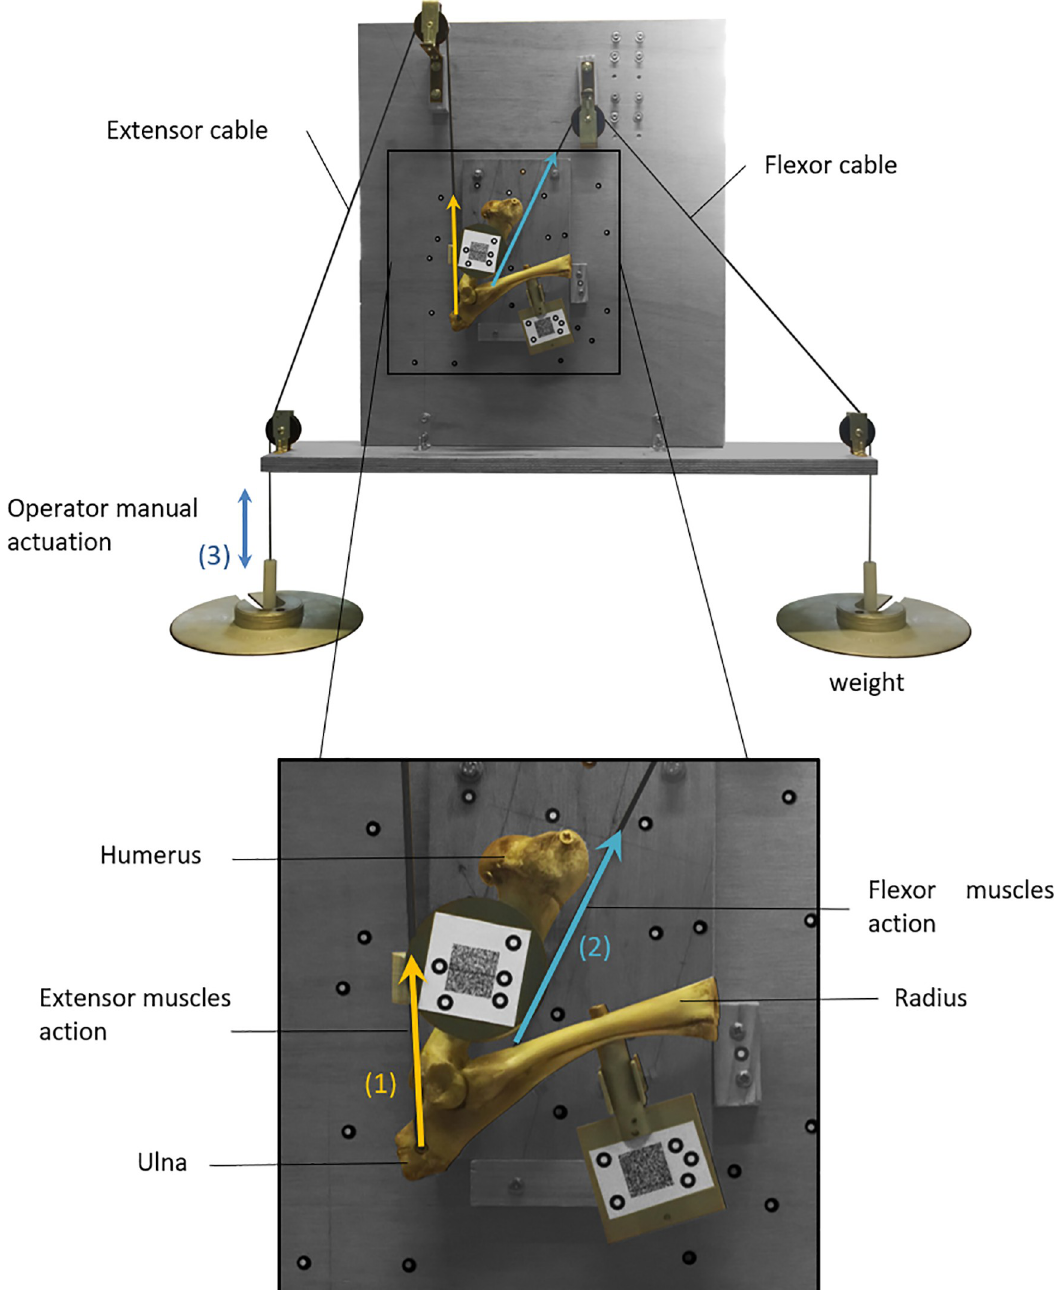
Fig 3. Sheep elbow test rig. (1) Extension force. (2) Flexion force. (3) Manual